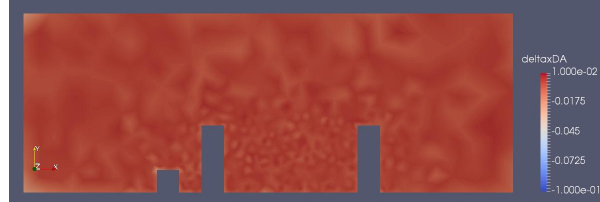
Fig. 6 Results of the VarDA algorithm with (cid:28)(cid:28)(cid:28) =5 EOFs for Pressure field.